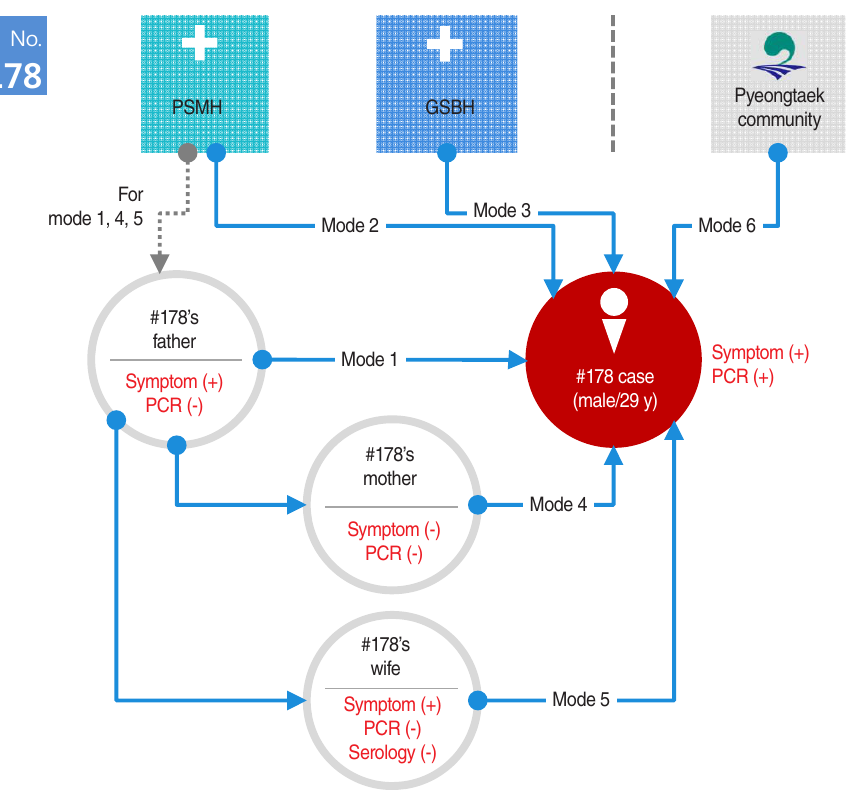
No. Figure 3. Two probable modes of transmission of 178th MERS case (see Table 1 for the number of transmission mode). Figure 2. Possible modes of transmission of the 178th MERS case (see Table 2 for the number of transmission mode). MERS, Middle East Respiratory Syndrome; PSMH, Pyeongtaek St. Mary’s Hospital; GSBH, Good Samaritan Bagae Hospital; PCR, polymerase chain reaction.